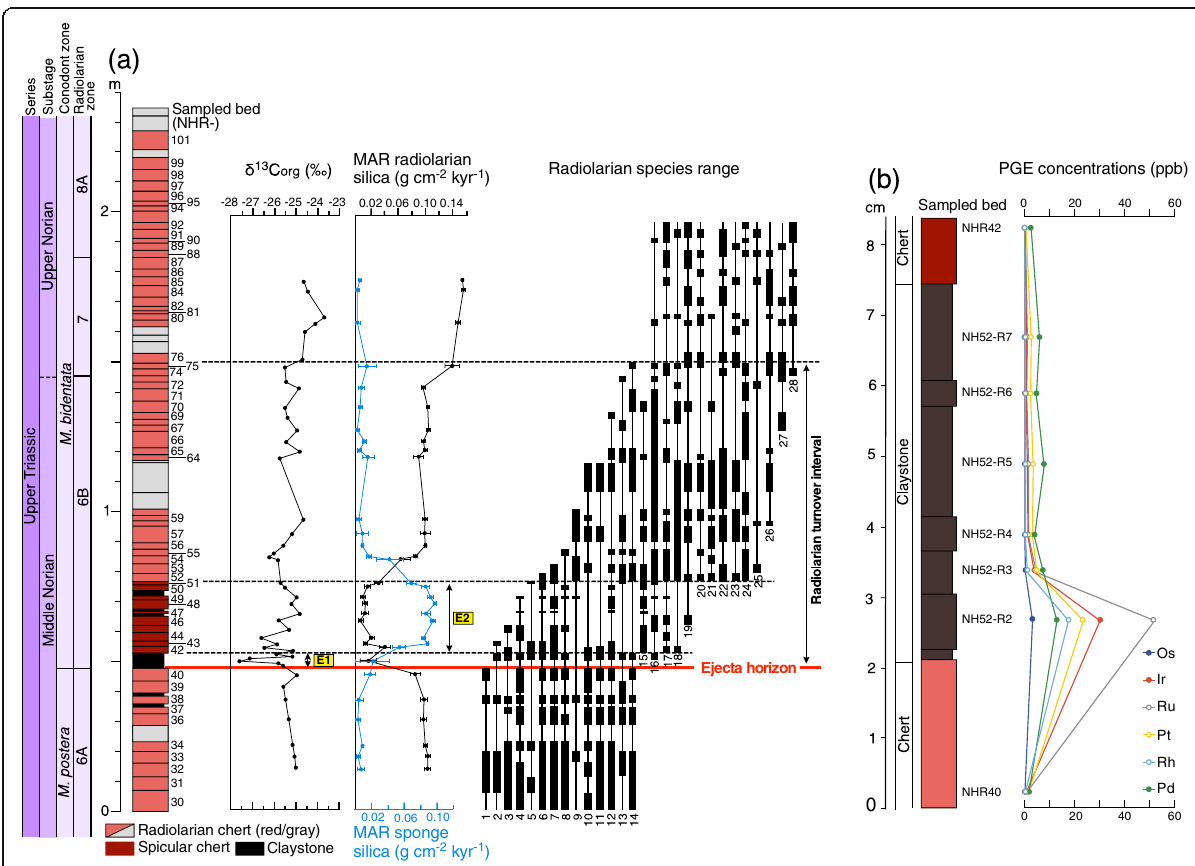
Fig. 3 Biostratigraphy and chemostratigraphy of the bedded cherts in the Sakahogi section (Onoue et al. 2016a; Sato et al. 2016). a Stratigraphic profiles of organic carbon isotopes, mass accumulation rates of biogenic silica, and radiolarian biostratigraphy. The mass accumulation rate of biogenic silica was estimated by assuming a constant sedimentation rate of 1.1 – 1.6 mm kyr − 1 in the middle – upper Norian chert succession (Onoue et al. 2016a), which is an alternative to a previous model assuming different sedimentation rates between chert and claystone (Hori et al. 1993). b Stratigraphic profiles of PGE concentrations in the claystones of the studied section. NH52-R2 indicates the lower sublayer of claystone (ejecta layer) with microspherules and Ni-rich